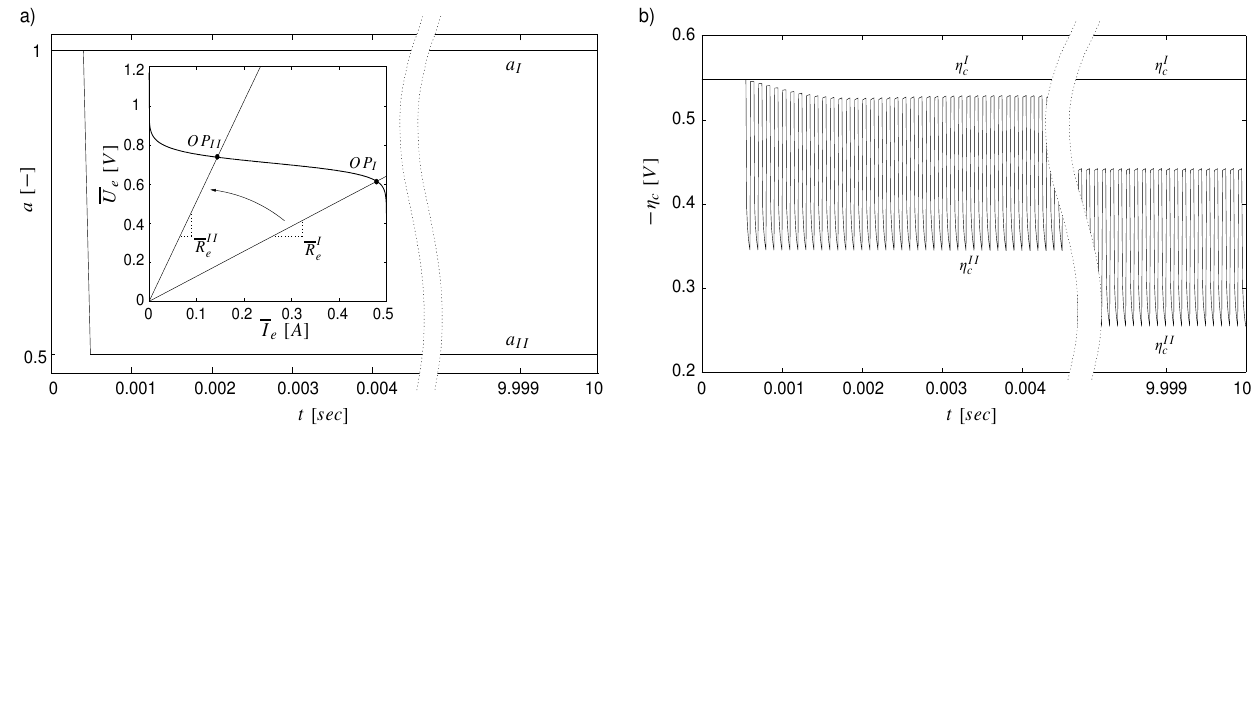
Figure 11. a) Time plot of duty ratio a and (inside) the stationary voltage-current profile of the fuel cell with considered operating points. In b) the step response of the overpotential η is shown.